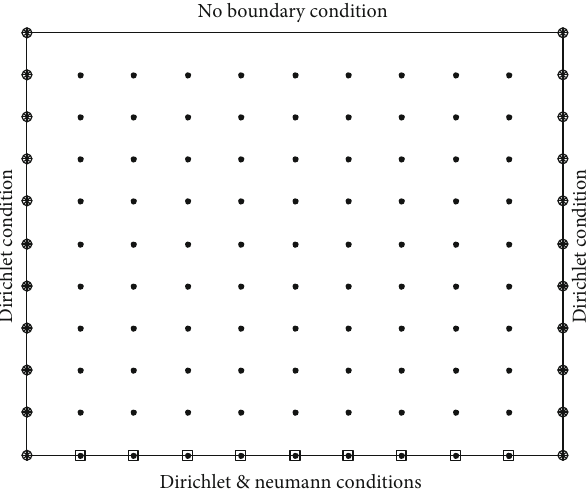
Figure 2: Domains for the second stationary heat problem.